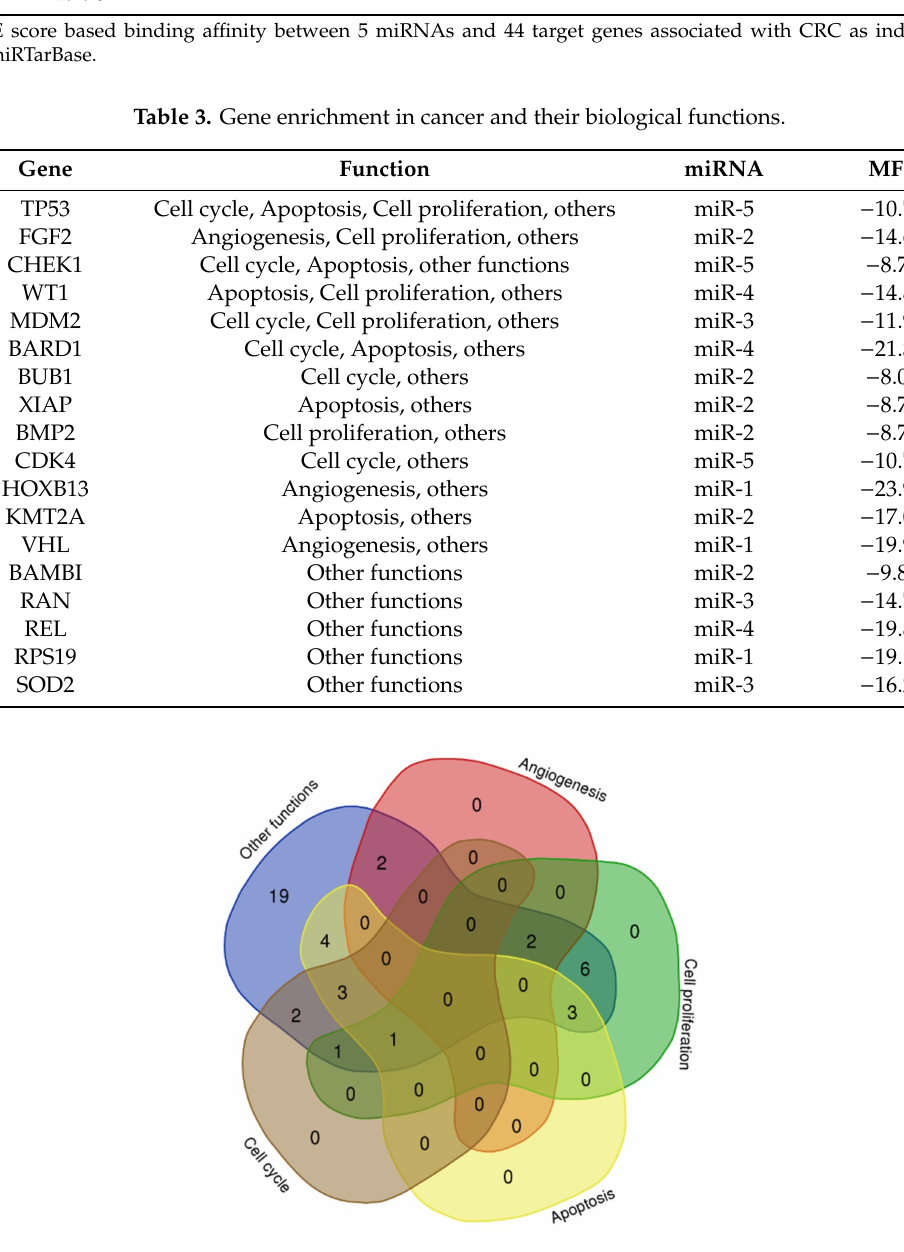
Figure 2. Biological processes of the microRNA target